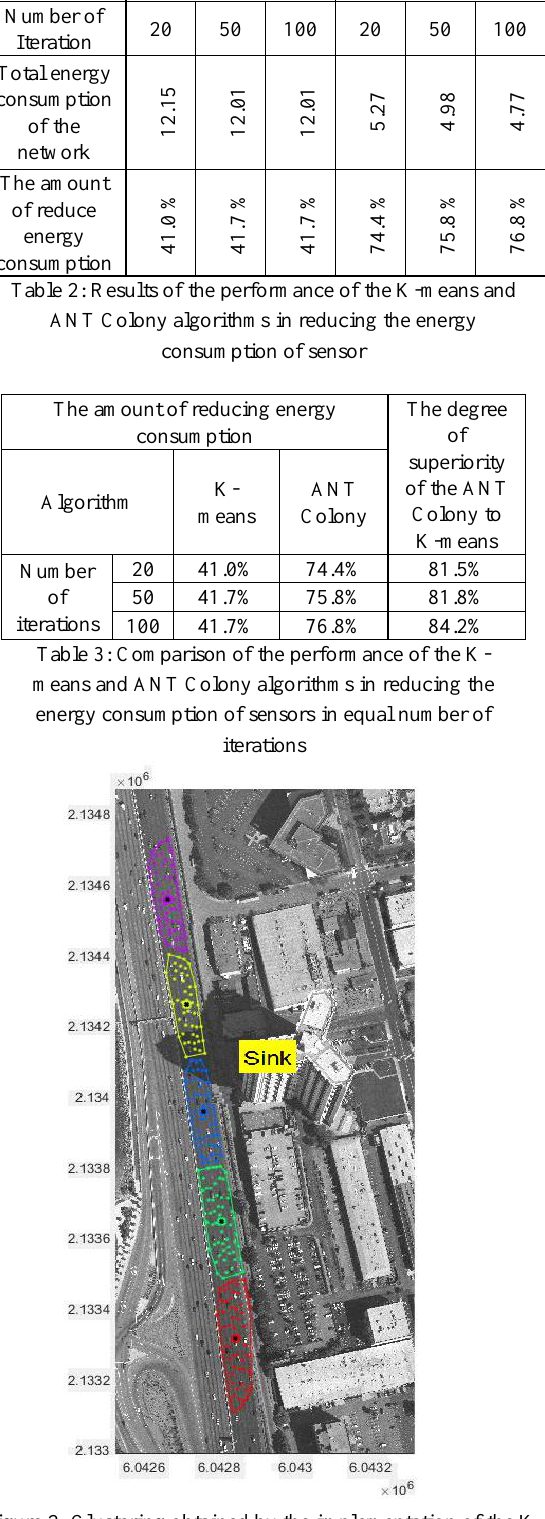
Figure 2: Clustering obtained by the implementation of the K- means algorithms in 100 iterations